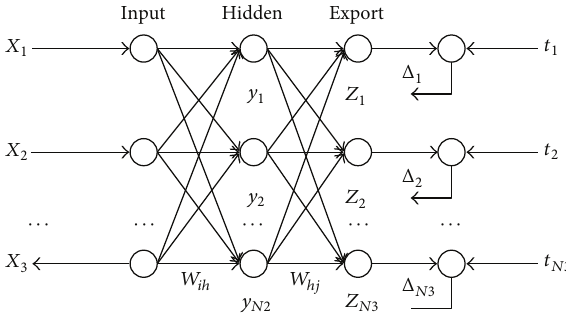
Figure 1: Three-layer BP neural network